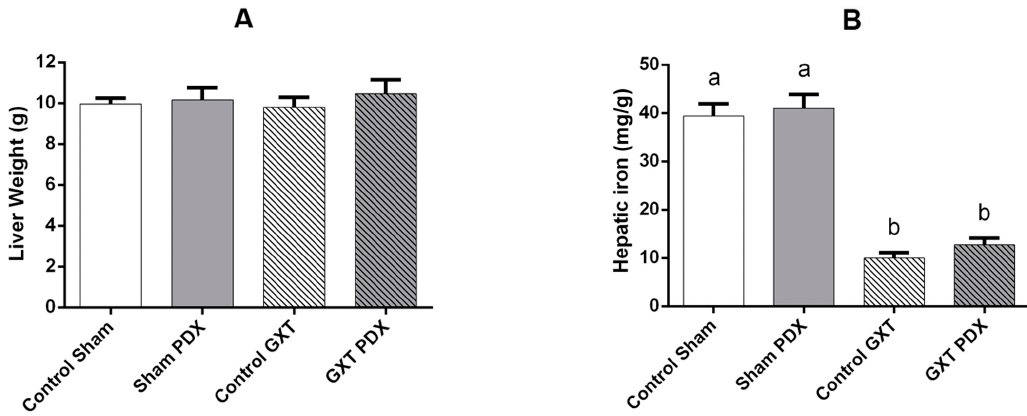
Figure 6. A : Liver weight (g) of the experimental groups. B : Iron concentrations in the liver (mg/g liver) of the experimental groups. Absence of letters and bars with same letters indicate no significant difference according to Tukey’s test ( p < 0.05). Different letters indicate a significant difference to the Tukey test ( p < 0.05). Sham Control: sham without polydextrose; Sham PDX: sham with polydextrose (7.5%); GXT Control: gastrectomized without polydextrose; GXT PDX: gastrectomized with polydextrose (7.5%). Values expressed as mean ±